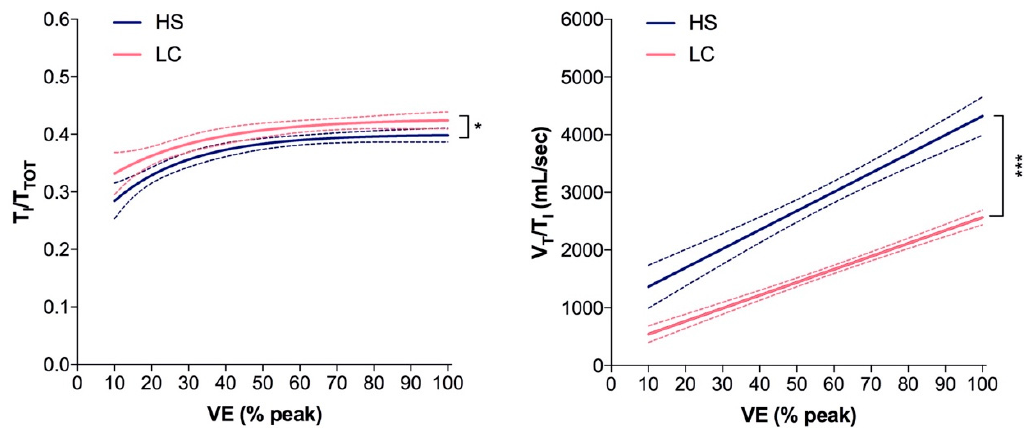
Figure 2. Best fitting curves of data points of T I /T TOT ( left panel ) and V T /V I ( right panel ) and 95% confidence bands during exercise in 42 Long-COVID patients and 40 healthy subjects. * p < 0.05; *** p < 0.001.